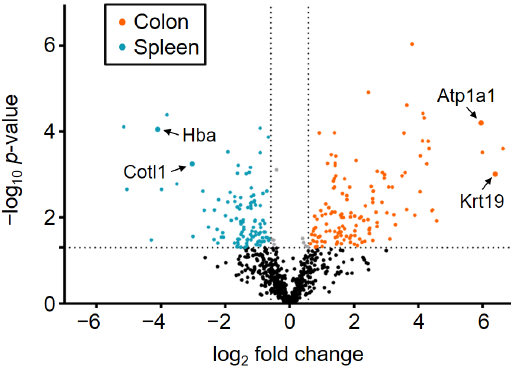
Figure 4. Volcano plot showing the log 2 fold change values of 715 proteins plotted against their associated − log 10 p -values. Dots representing individual proteins were divided in four different groups: p -value > 0.05 (black); p -value < 0.05 (grey); p -value < 0.05, 1.5-fold higher abundance in colon (orange); p -value < 0.05, 1.5-fold higher abundance in spleen (blue). For both sample groups two proteins, being typical higher abundant in colon or spleen tissue, respectively are highlighted and named (see Supplementary Table